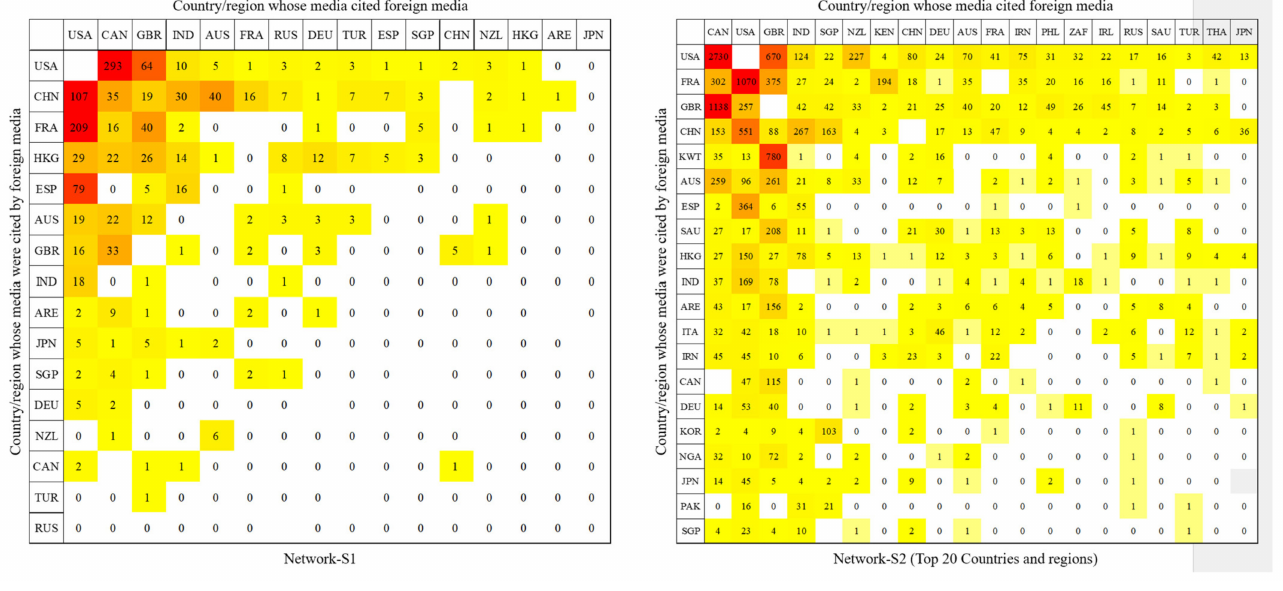
Figure 9. Media citations at the national level in the